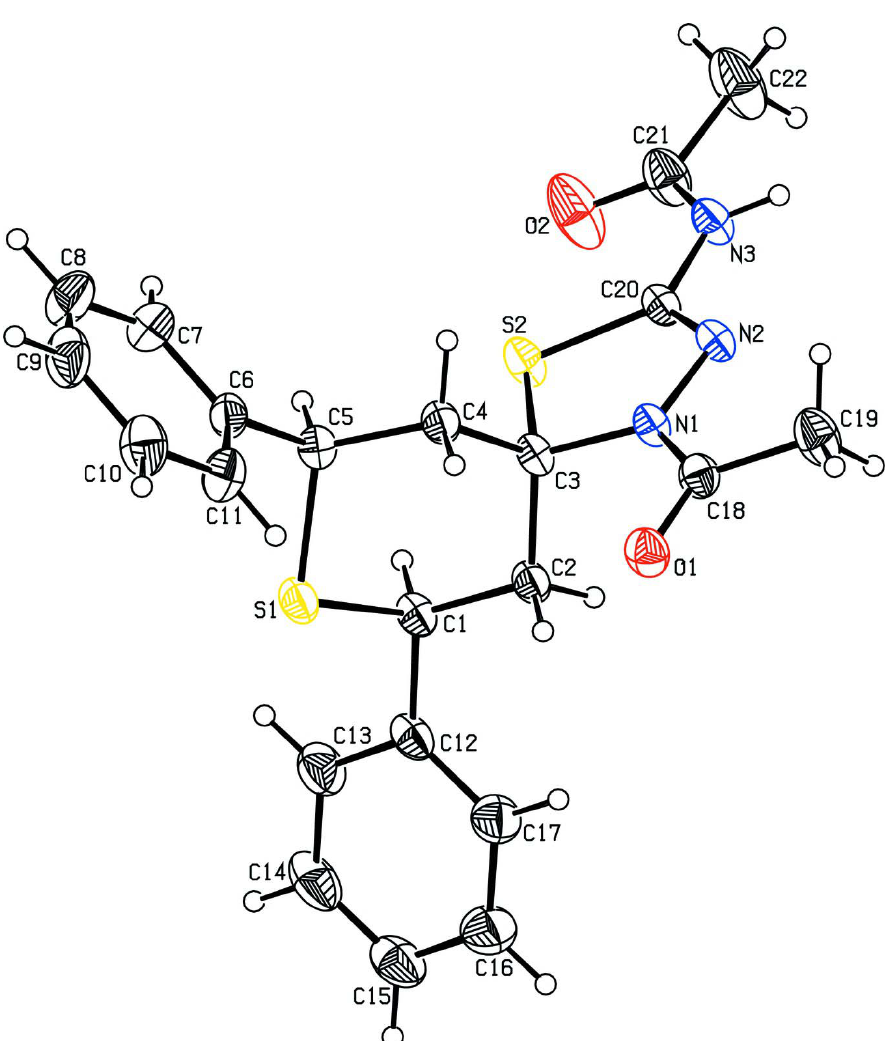
Figure 1 The molecular structure of (I), with atom labels and 30% probability displacement